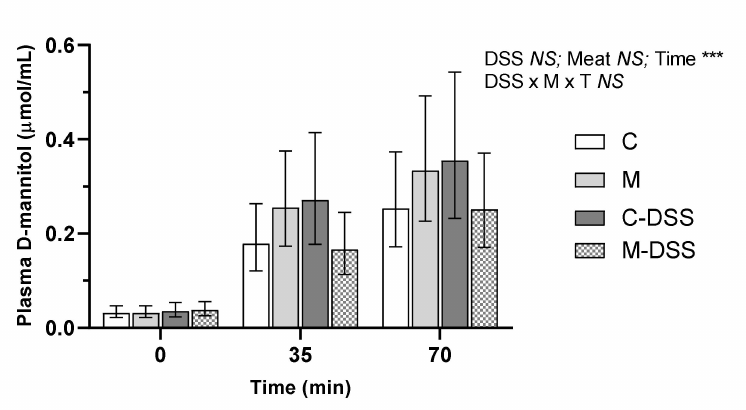
Figure 3. E ff ect of red meat supplementation and DSS treatment on in vivo gut permeability. Values represent LS means ± 95% confidence limits due to logarithmic transformation of data. Control diet, C ( n = 6), meat diet, M ( n = 6), control diet + DSS, C-DSS ( n = 5), meat diet + DSS, M-DSS ( n = 6). NS = non-significant, *** p <